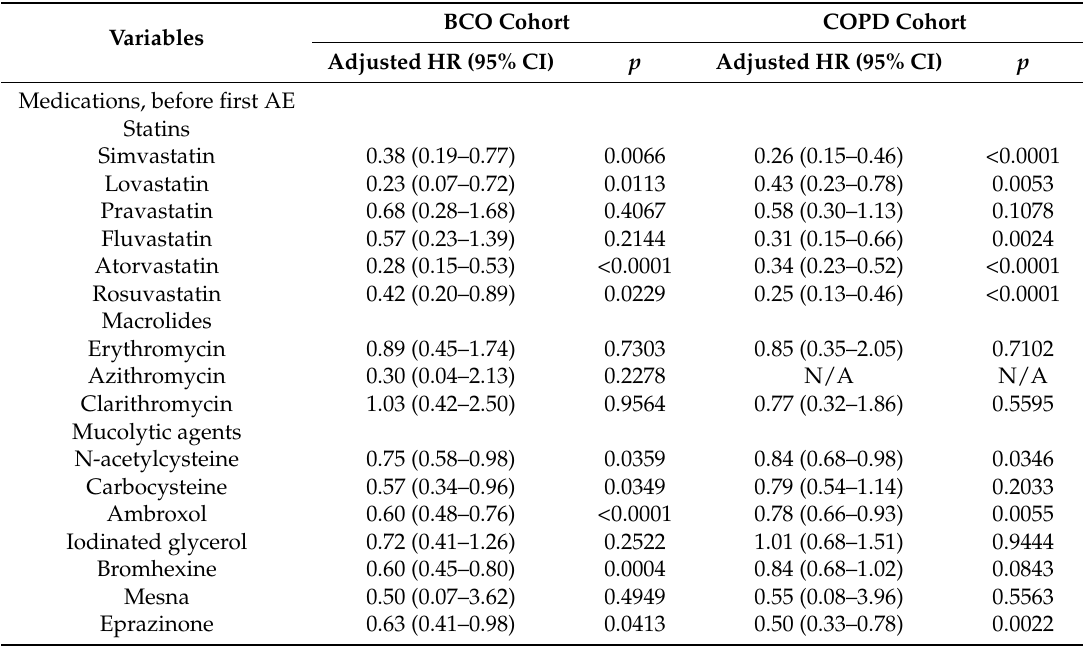
Table 4. Medication effects on acute exacerbations in the bronchiectasis-COPD overlap (BCO) and chronic obstructive pulmonary disease (COPD) alone